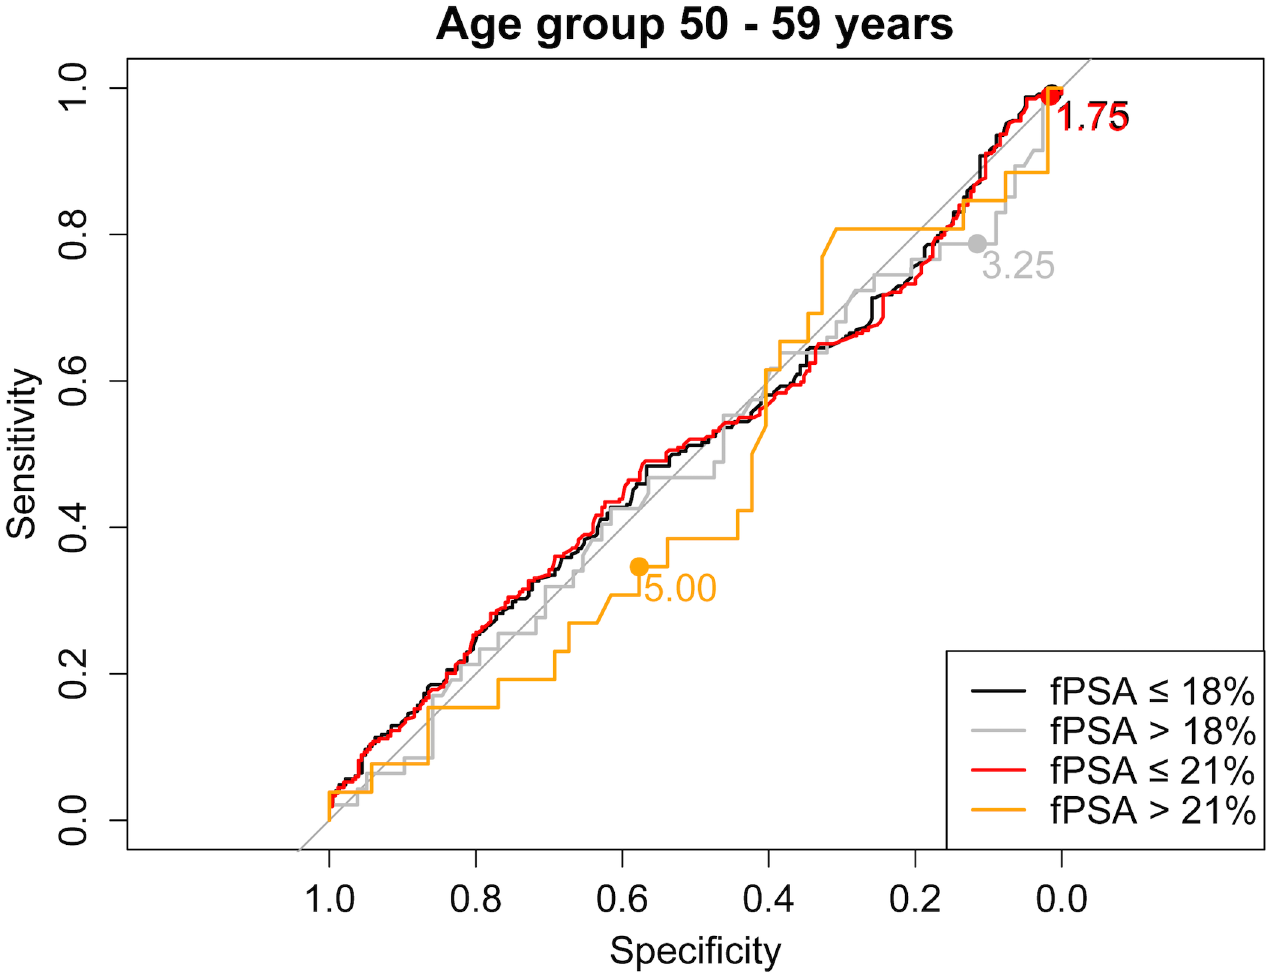
Fig 2. ROC curve for the age group (cid:1) 50 – 59 years stratified for fPSA values (cid:1) 18% vs. > 18% and (cid:1) 21% vs. > 21%, respectively.